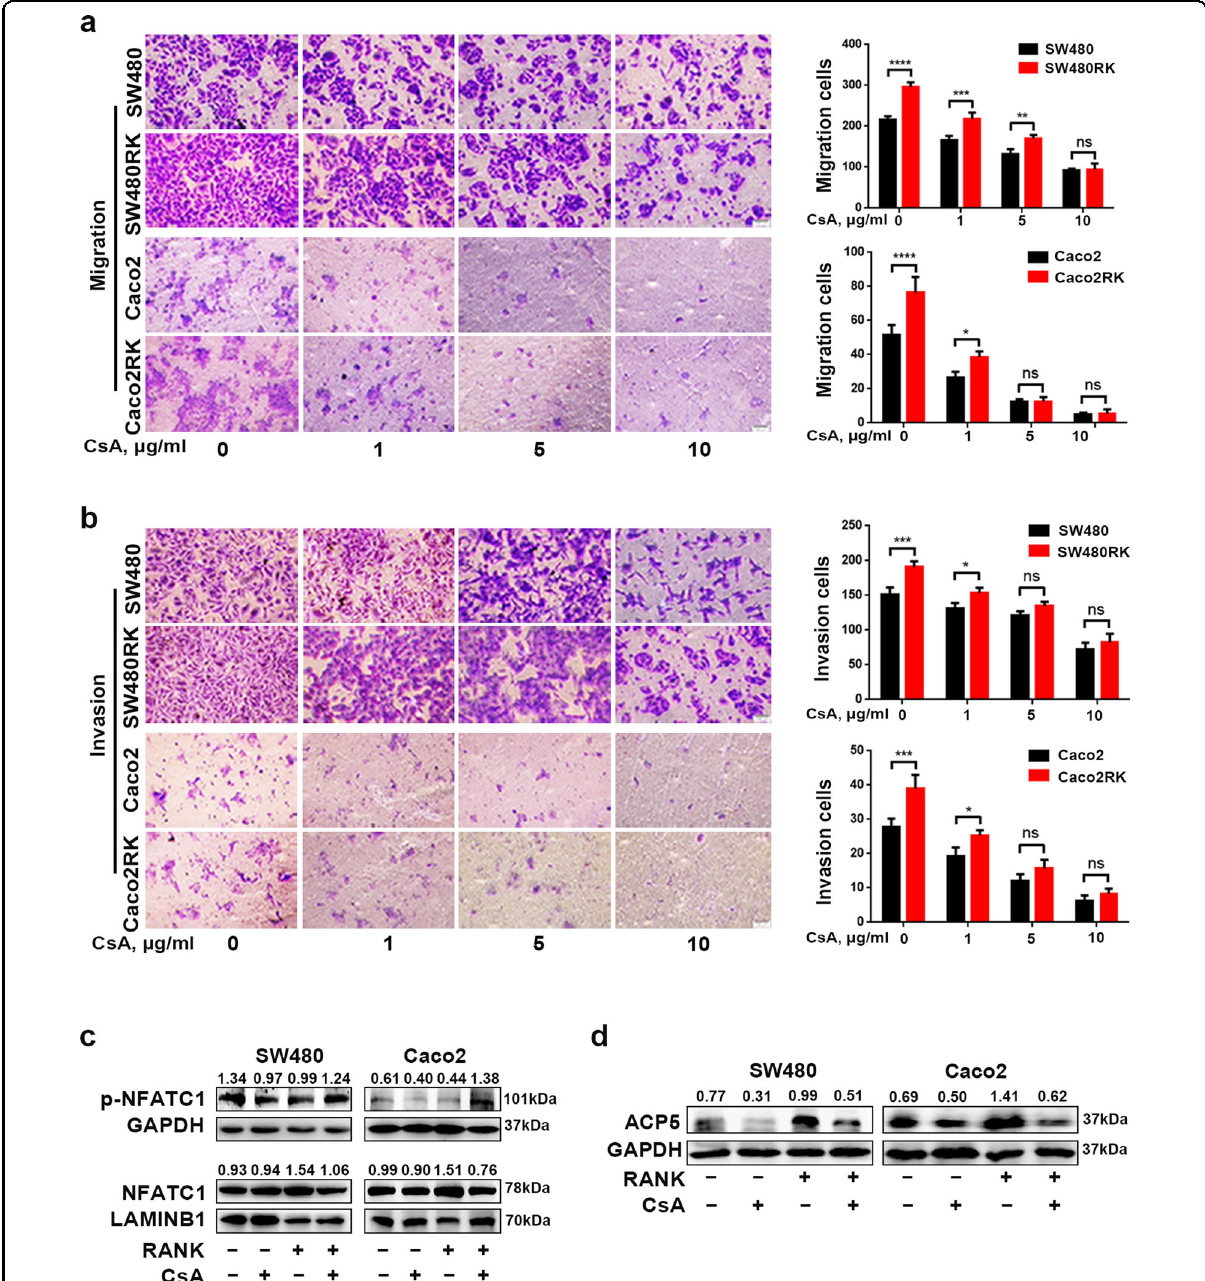
Fig. 5 RANK-induced NFATC1-ACP5 activity was regulated by calcineurin. a , b Cyclosporin A (CsA) gradually attenuated RANK-induced migration and invasion in SW480 and Caco2 cells at 1, 5, and 10 μ g/ml. Scales bars = 100 μ m. c A total of 10 μ g/ml CsA signi fi cantly decreased the nuclear translocation of NFATC1 in SW480RK and Caco2RK cells analyzed by western blotting. d Western blotting showed that 10 μ g/ml CsA reversed the ACP5 levels in RANK -overexpressing CRC cells. Data are mean ± SD ( n = 3). * P < 0.05, ** P < 0.01, *** P < 0.001, **** P <